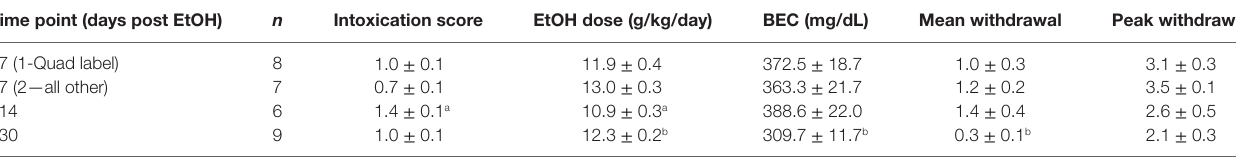
TaBle 2 | Binge intoxication parameters. Time point (days post